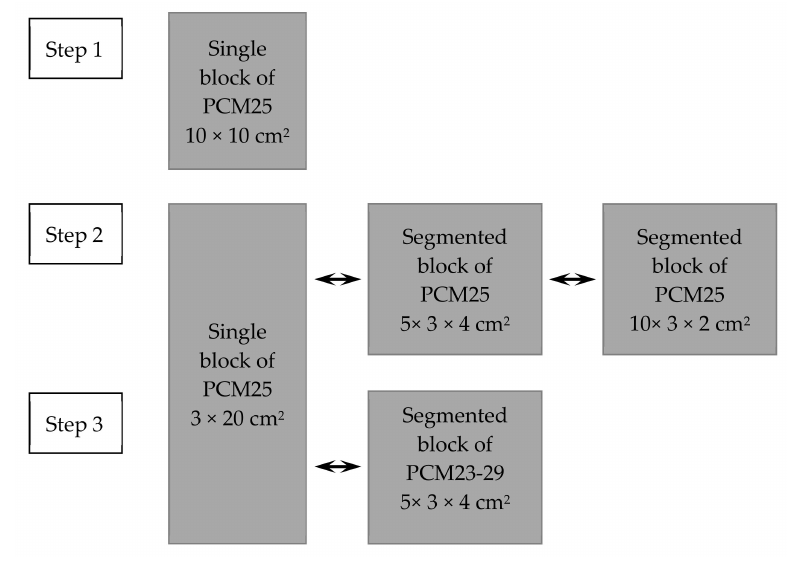
Figure 6. Research overview.